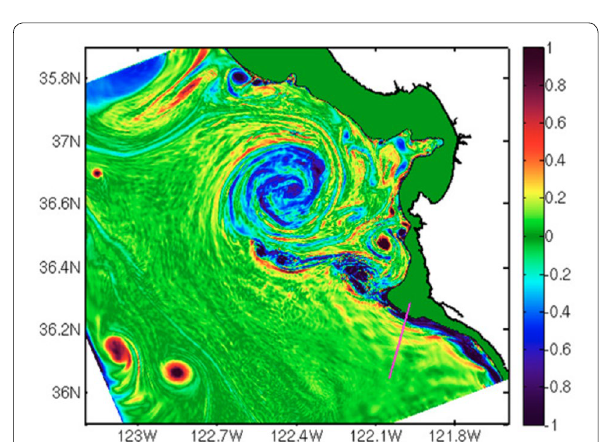
Fig. 17 Cuddy SCV generation by boundary current separation. California undercurrent eddies (Cuddies) form by separation of the California Undercurrent at the headland south of Monterey Bay, CA. This is a simulation snapshot of normalized vertical vorticity, ζ/ f , at 150 m depth. Anticyclonic (blue) vorticity is generated by the bottom drag along the slope and flows north until it separates near Pt. Sur, CA. Centrifugal instability occurs, wake vortices emerge, and then, these smaller vortices merge into a larger Cuddy, seen here in the middle of the Bay at an intermediate stage of self-organization. Subsequently, Cuddies disperse into the interior Pacific by mesoscale currents (Molemaker et al. 2015)